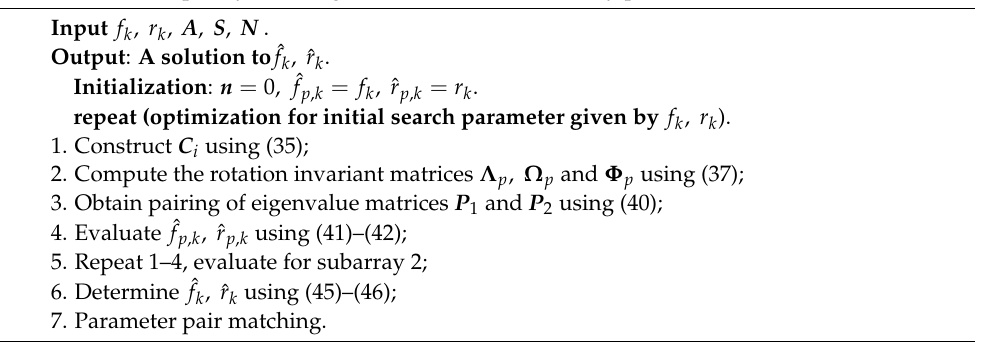
Algorithm 3: Frequency and range estimation of the subarray